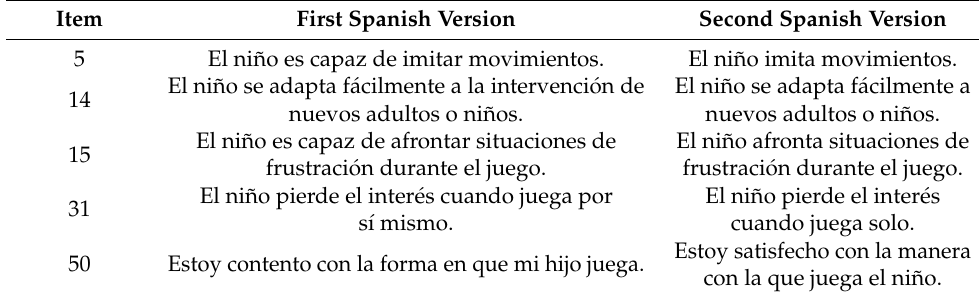
Table 1. Items modified by